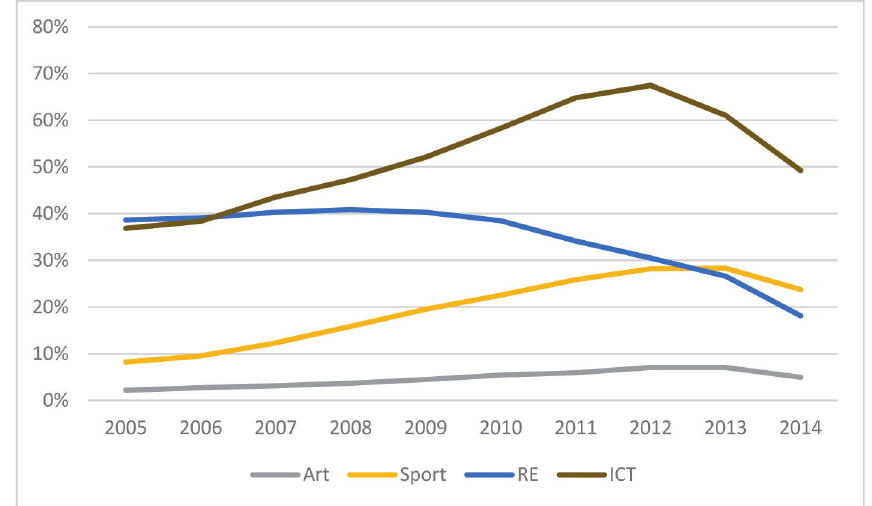
Figure 7: Percentage of pupils entered in qualifications other than GCSEs in art and design, ICT, PE/ sport studies, and religious education 2005 to